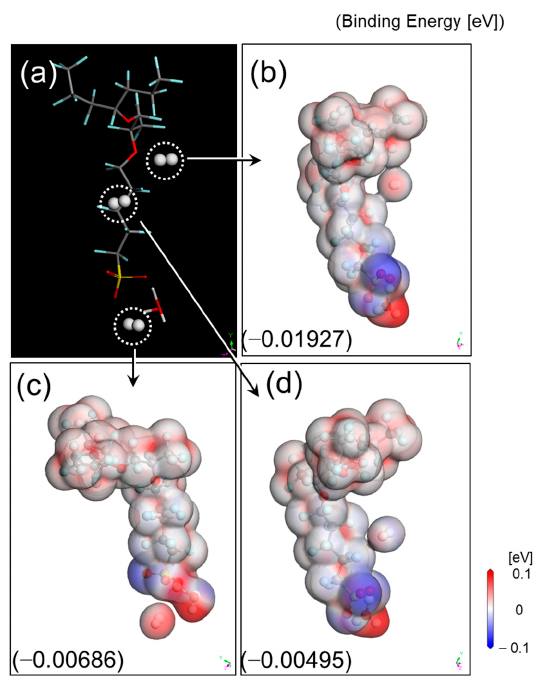
Figure 5. ( a ) Binding energy of hydrogen molecules on side chain with adsorbed H 3 O + ; ( b ) possible positions for the adsorption of H 2 molecules; ( c ) charge distribution; and ( d ) binding energy.